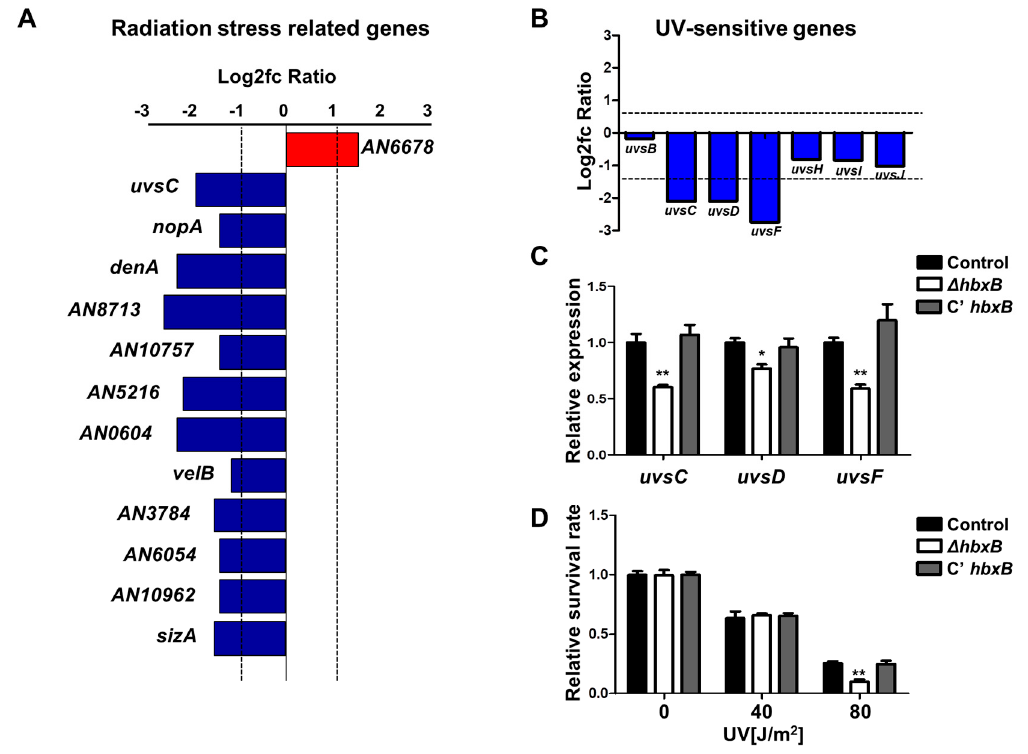
Figure 2. Role of hbxB on UV stress tolerance in Aspergillus nidulans conidia. ( A – C ) mRNA expression of genes associated with radiation stress gene clusters in hbxB deletion mutant conidia ( p < 0.05, log2fc > 1.0). ( B ) mRNA levels of genes involved in UV-sensitive gene clusters in hbxB deletion mutant conidia. ( C ) mRNA expression of uvsC , uvsD , and uvsF in control (TNJ36), ∆ hbxB (TSH1.1), and C’ hbxB (TSH7.1) strain conidia were verified by qRT-PCR analysis. * p < 0.05; ** p < 0.01, differences between control and ∆ hbxB conidia. ( D ) UV sensitivity of control (TNJ36), ∆ hbxB (TSH1.1), and C’ hbxB (TSH7.1) strain conidia. ** p < 0.01, differences between control and ∆ hbxB conidia.